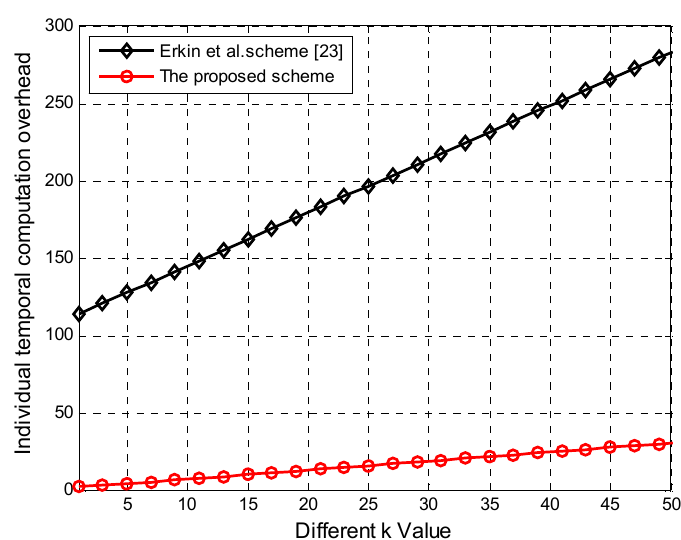
Figure 5. Variety of temporal computation overhead per node with the value k.